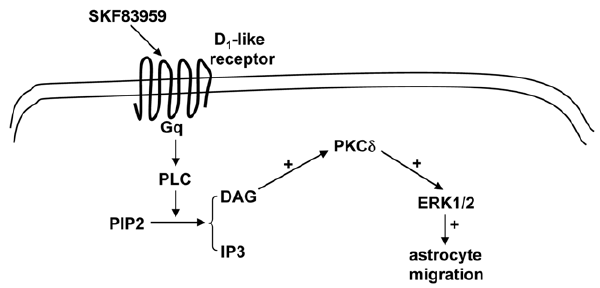
Figure 7. Proposed scheme for the signaling pathways downstream of SKF83959-induced ERK1/2 phosphorylation in cultured rat astrocytes.